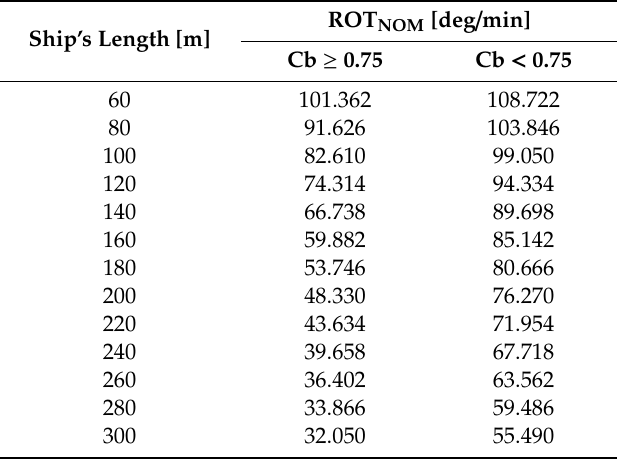
Figure 2. Rates of turn (ROT) of ships of various lengths and block coe ffi cients of the hull [7]. Table 1. Nominal ROT in fairway